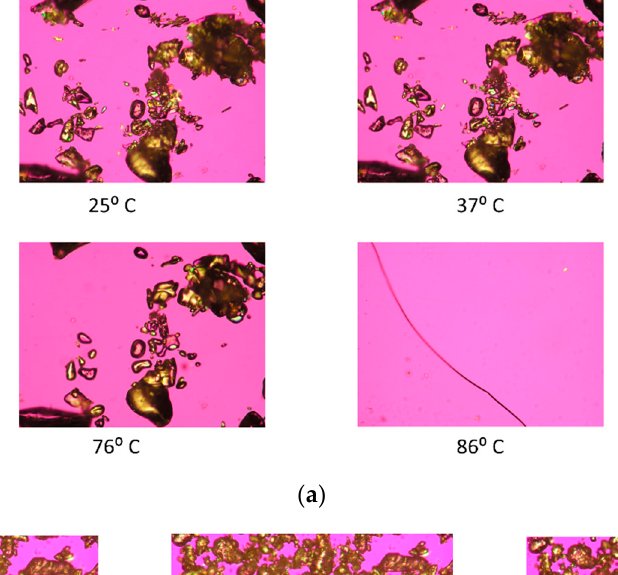
Table 2. Physical properties of raw TMP and spray dried (SD) TMP. ( n = 3, Mean ± SD).